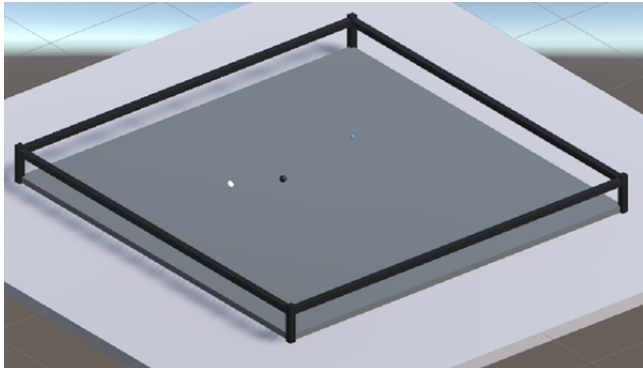
Figure 10. Sample Configuration space, with α (gray), β (black)–tubulins and GTP (teal)